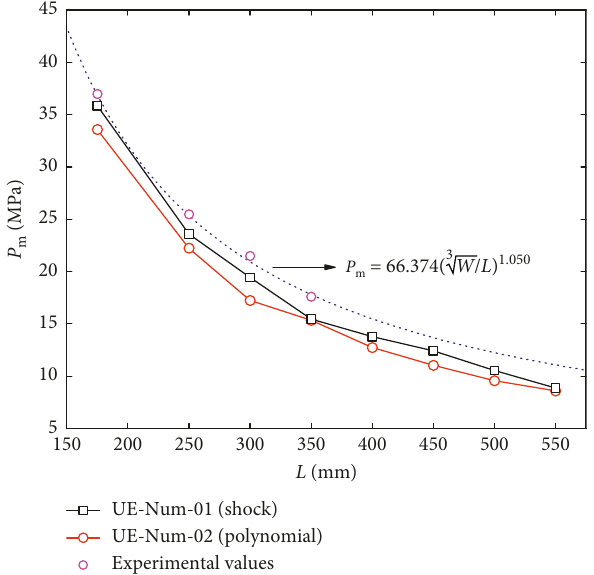
Figure 9: Shock wave peak pressures under different state equations. Table 7: Comparison between numerical results of bubble pul- sation with different water state equations and test results.